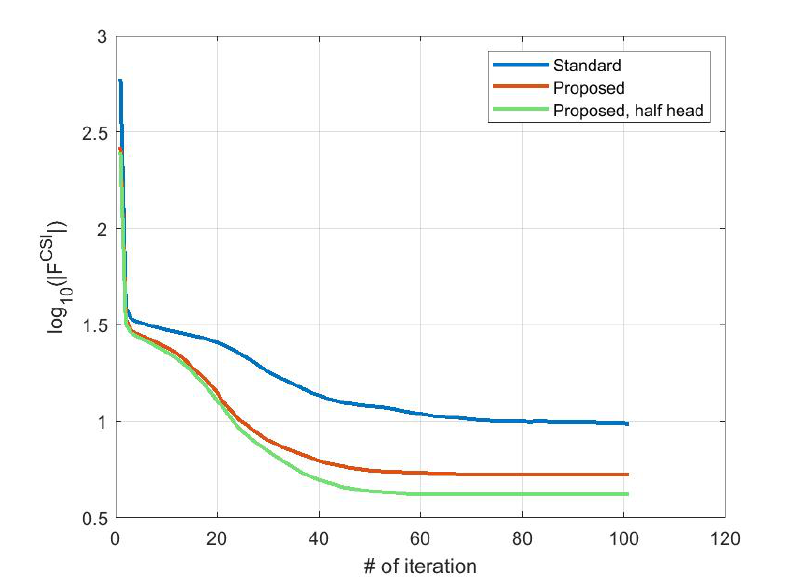
Figure 12. Cost functional in (5) during the iterations in a logarithmic scale: standard discretization (blue line), proposed discretization (red line), and proposed discretization with half head (green